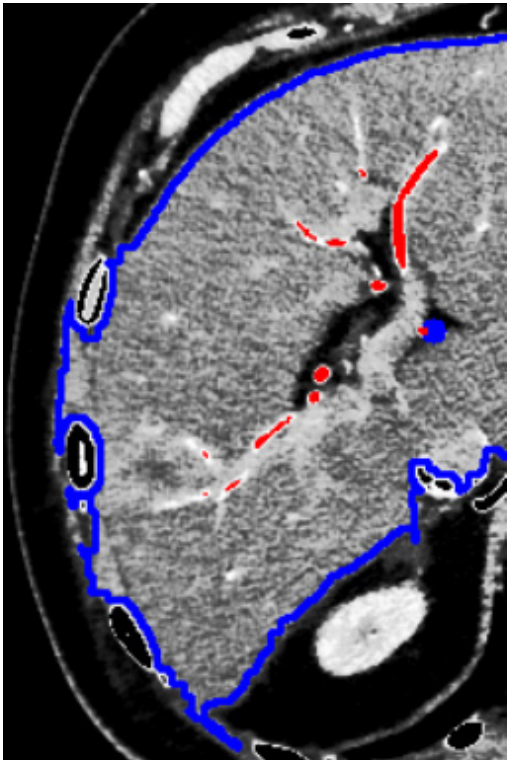
Figure 1. Problems in liver segmentation. The similar density of the hepatic parenchyma and adjacent neighboring tissues is a significant problem in separating the liver and therefore creating the complete 3D model. The blue color line is providing the border of the liver as it has been defined by a simple digital image processing algorithm, while red areas inside the liver are depicting the vessels which are visible at the specific image/slice of the DICOM image series.